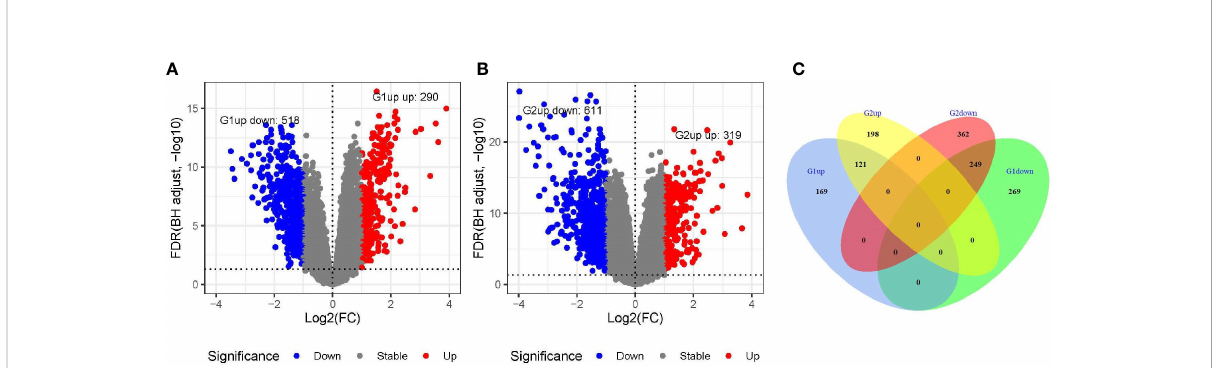
FIGURE 1 Screening of differentially expressed genes in GSE54236 (G1) and GSE121248 (G2) datasets. (A, B) Gene expression levels in GSE54236 (G1) and GSE121248 (G2) datasets, with blue dots indicating signi fi cantly low expression and red dots indicating signi fi cantly high expression. (C) The number of genes with high or low expression in both